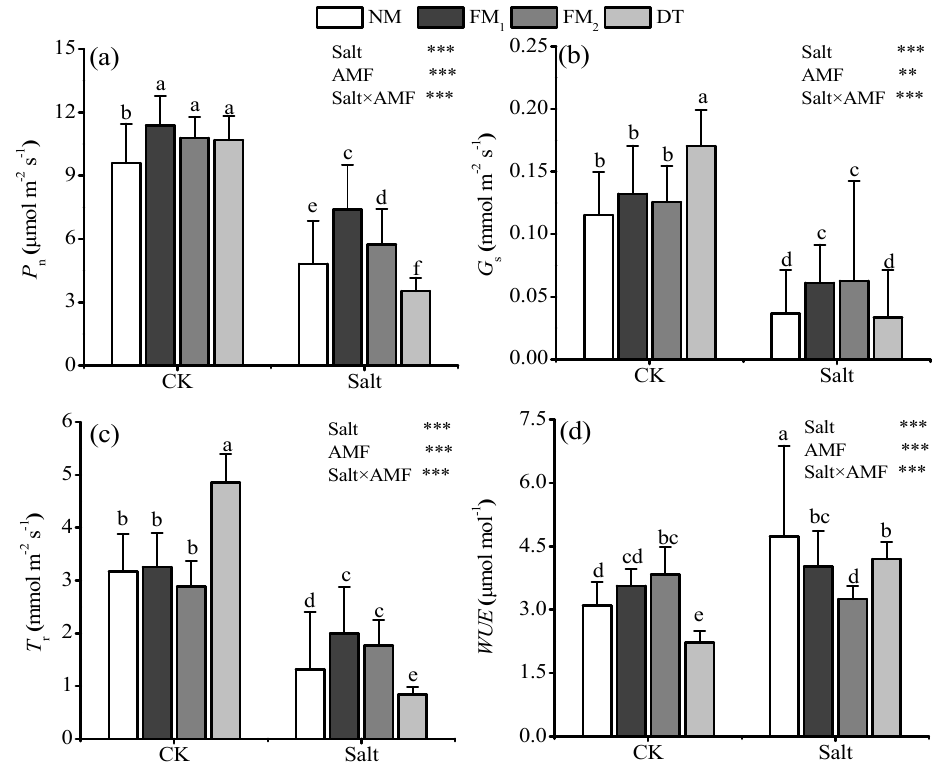
Figure 2. Effects of salt treatments and AMF inoculation on the plant net photosynthetic rate ( a ), stomatal conductance ( b ), transpiration rate ( c ), and water use efficiency ( d ) of Z. serrata seedlings leaves. Vertical bars indicate the standard error of the mean ( n = 9). Different lowercase letters indicate significant differences between the three AMF under control and salt stress at the 0.05 significance level; NS not significant, ** p < 0.01, *** p < 0.001.